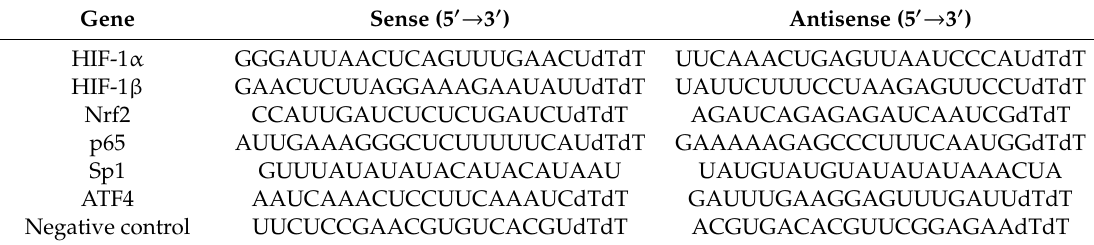
Table 1. Sequences of sense and antisense siRNA